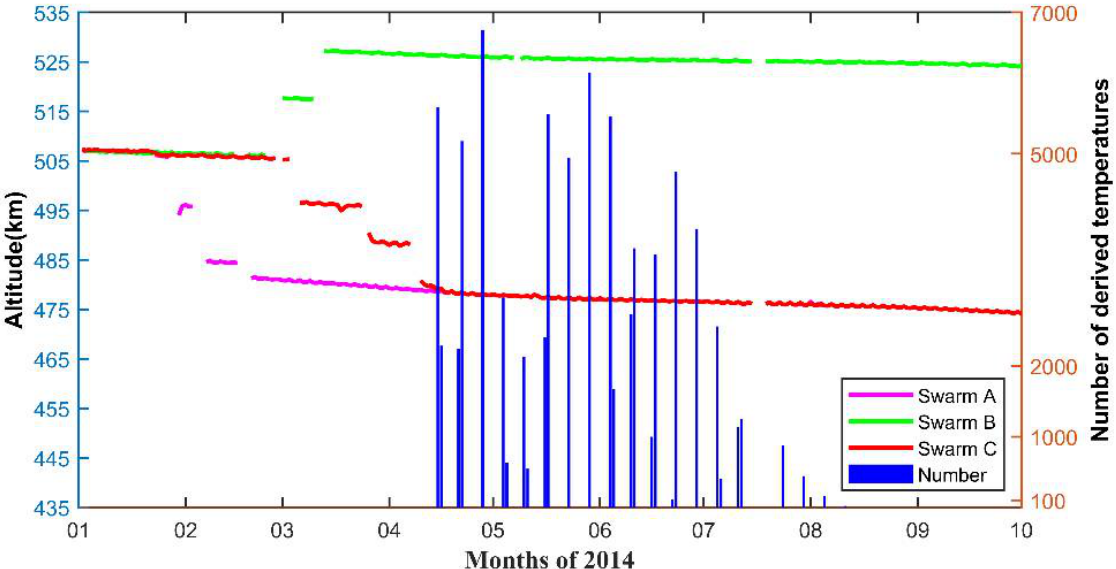
Figure 3. Time distribution of inversion temperatures from January 2014 to October 2014, the result number is the number of points in the low and middle latitudes.